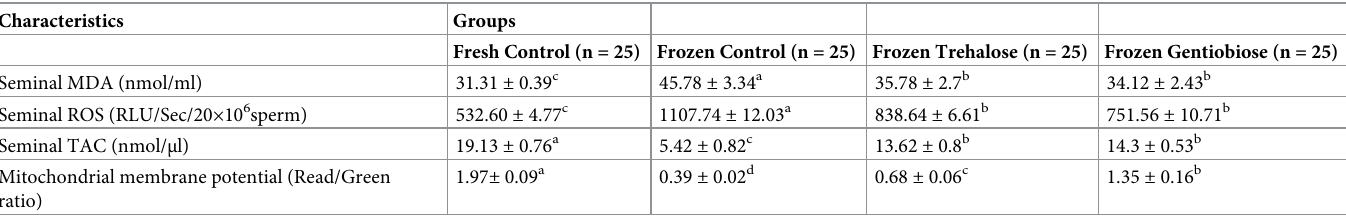
Table 2. Comparison of MDA, ROS, TAC and mitochondrial membrane potential among the experimental groups. Characteristics